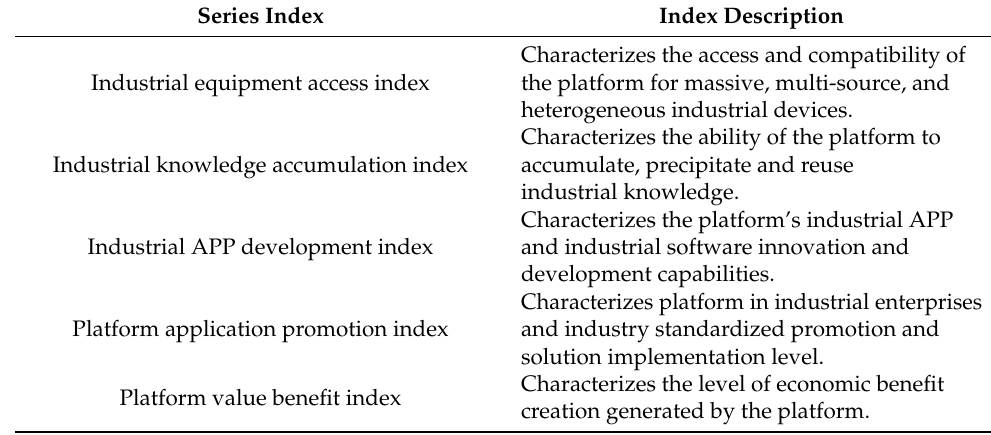
Table 3. Series Development Index of Industrial Internet Platform and the Description.